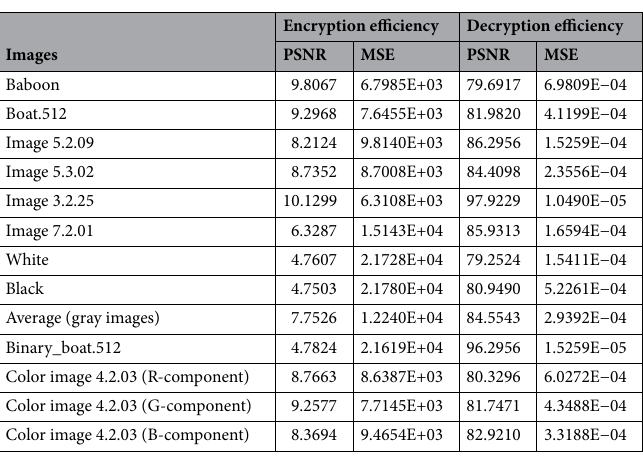
Table 2. PSNR and MSE.